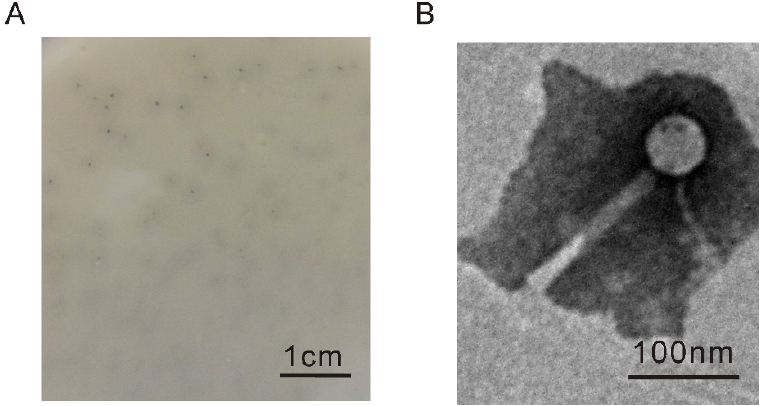
Figure 1. The morphology characteristics of phage vB_EcoM_APEC. ( A ) Plaque morphology of phage vB_EcoM_APEC; ( B ) virion morphology observation of phage vB_EcoM_APEC under TEM.